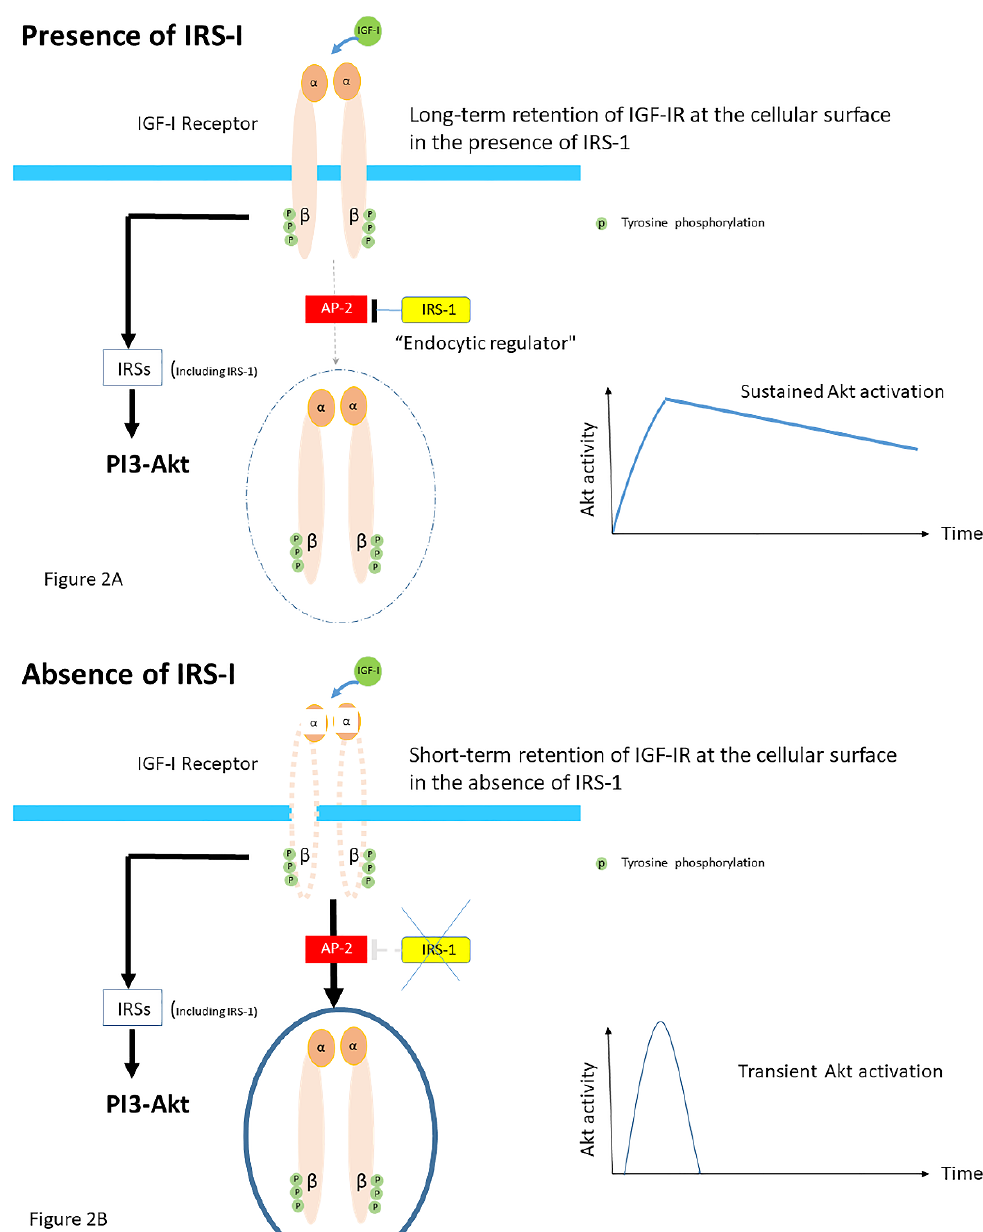
Figure 2. Proposed role of Insulin receptor substrate-1 (IRS-1). IRS-1 modulates how long ligand-activated IGF-IR remains at the cell surface before undergoing endocytosis in mammalian cells. IRS-1 interacts with the clathrin adaptor complex AP2. ( A ) In the presence of the IRS-1 / AP2-complex in the cell IGF-IR endocytosis after the ligand stimulation is delayed. Mechanistically, IRS-1 inhibits the recruitment of IGF-IR into clathrin-coated structures; for this reason, IGF-IR avoids rapid endocytosis and prolongs its activity on the cell surface and this results in sustained activation of the AKT pathway. ( B ) In absence of IRS-1/AP2- complex in the cell, there is only short-term retention of the IGF-IR at the cell surface and IGF-IR endocytosis is accelerated. This results in a transient activation of the AKT pathway (Modified from Yoneyama et al. IRS-1 acts as an endocytic regulator of IGF-I receptor to facilitate sustained IGF signaling. eLIFE, 2018; 7. pii: e32893).